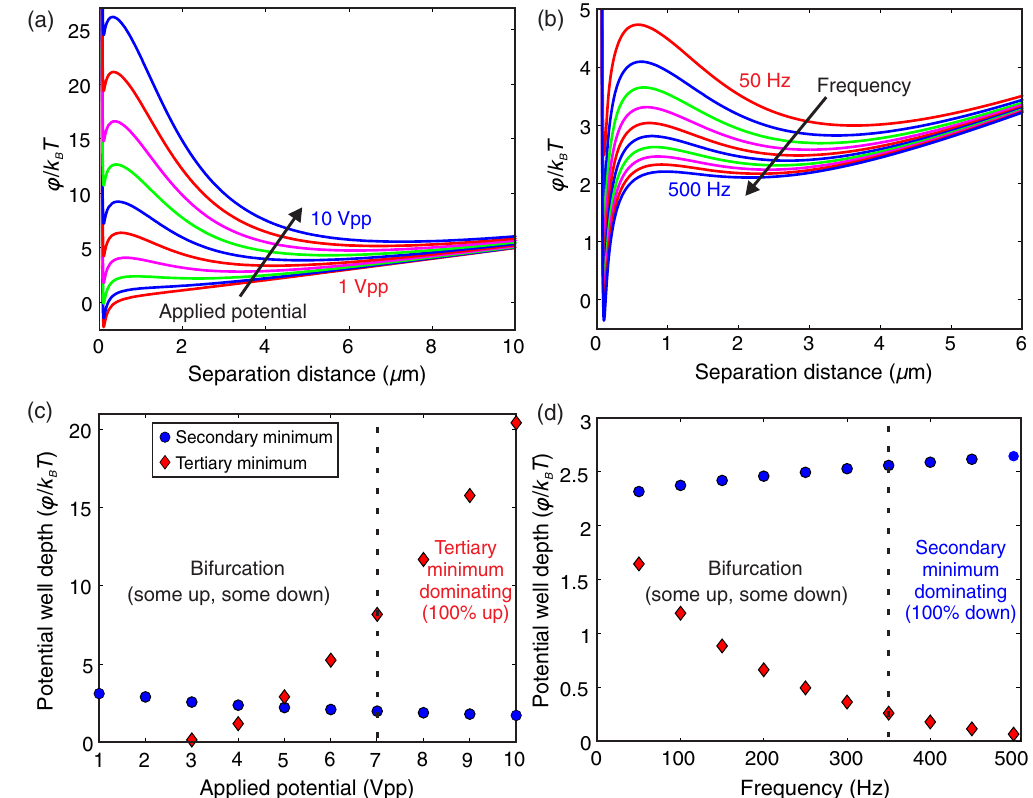
FIG. 6. Electric field dependence of the particle-electrode interaction potential for particles suspended in 1 mM NaOH, calculated using Eq. (1). (a) Interaction potential as a function of voltage at 100 Hz (1 Vpp voltage steps between subsequent potential curves). (b) Interaction potential as a function of frequency at 4 Vpp (50 Hz frequency steps between subsequent potential curves). (c), (d) Potential well depths of the secondary and tertiary minima as a function of applied potential (c) and frequency (d). The well depth is measured from the inflection point between the two minima. The vertical dashed lines denote the experimentally observed regimes shown in Fig.